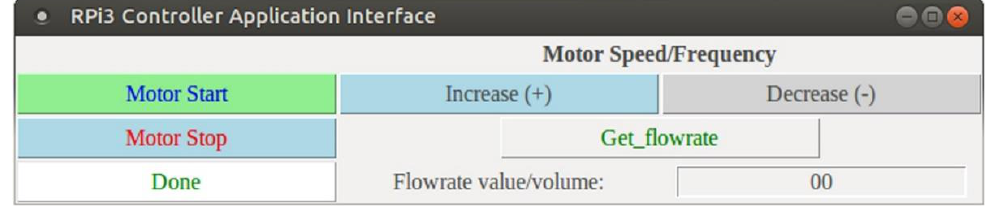
Figure 10. COTS-based controller simple application interface.